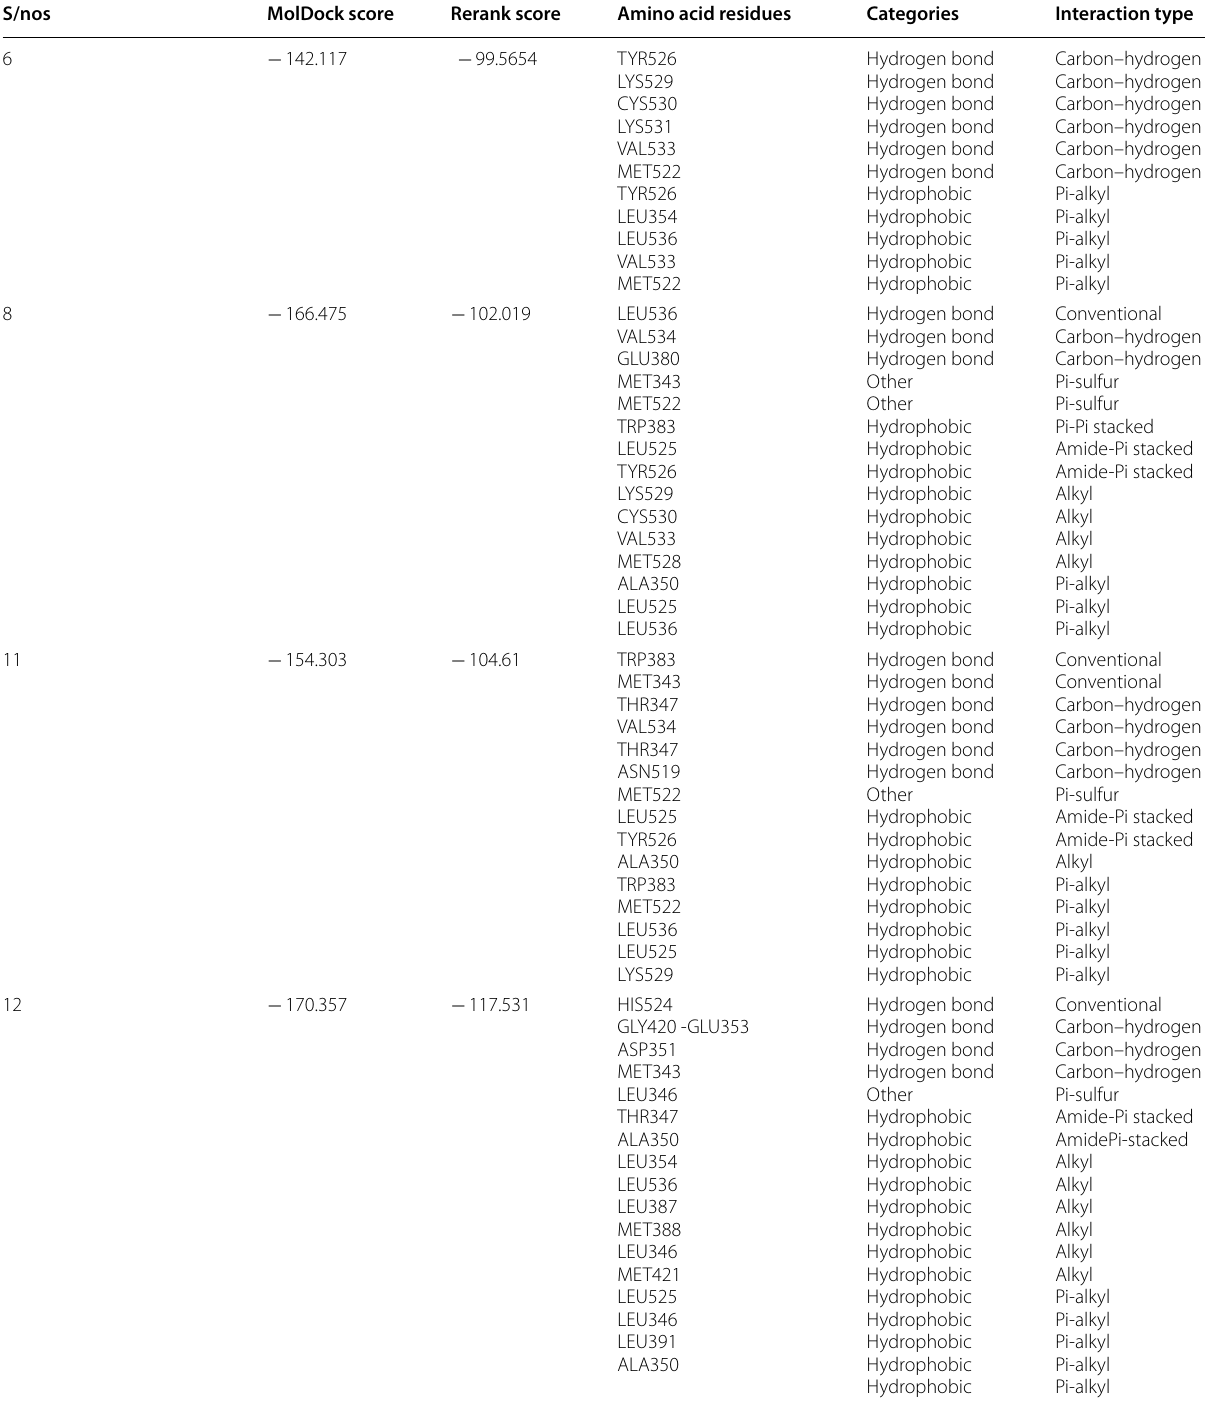
Table 9 Docking scores and various kinds of interactions of the designed chromen-2-ones and the active site of the ER + receptor